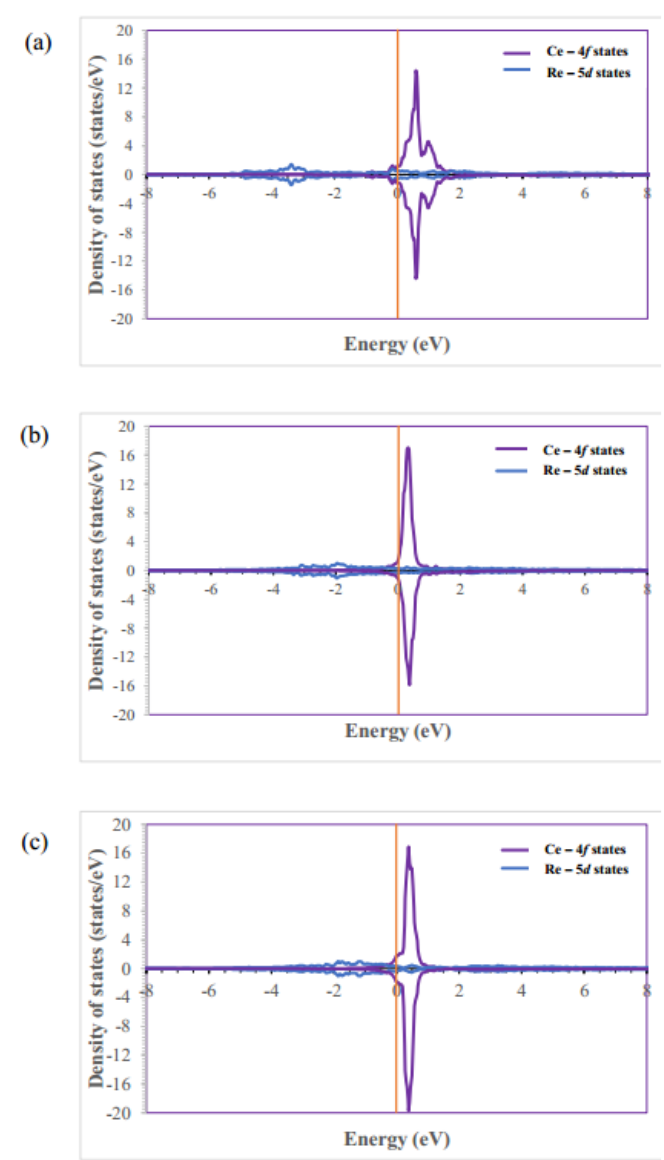
Figure 3. Partial Density of States (DOS) for 4 f -states of C e and 5 d -states of Re for the CeRe 2 Al 20 alloy calculated for the competed structures: ( a ) cubic; ( b ) tetragonal; ( c ) orthorhombic 1 c . Fermi energy is set to zero.